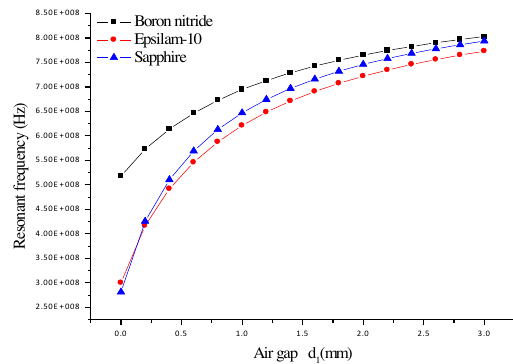
Figure 3: Resonant frequency versus air gap thickness for different anisotropic dielectric substrates, with r =1.59mm . d 2